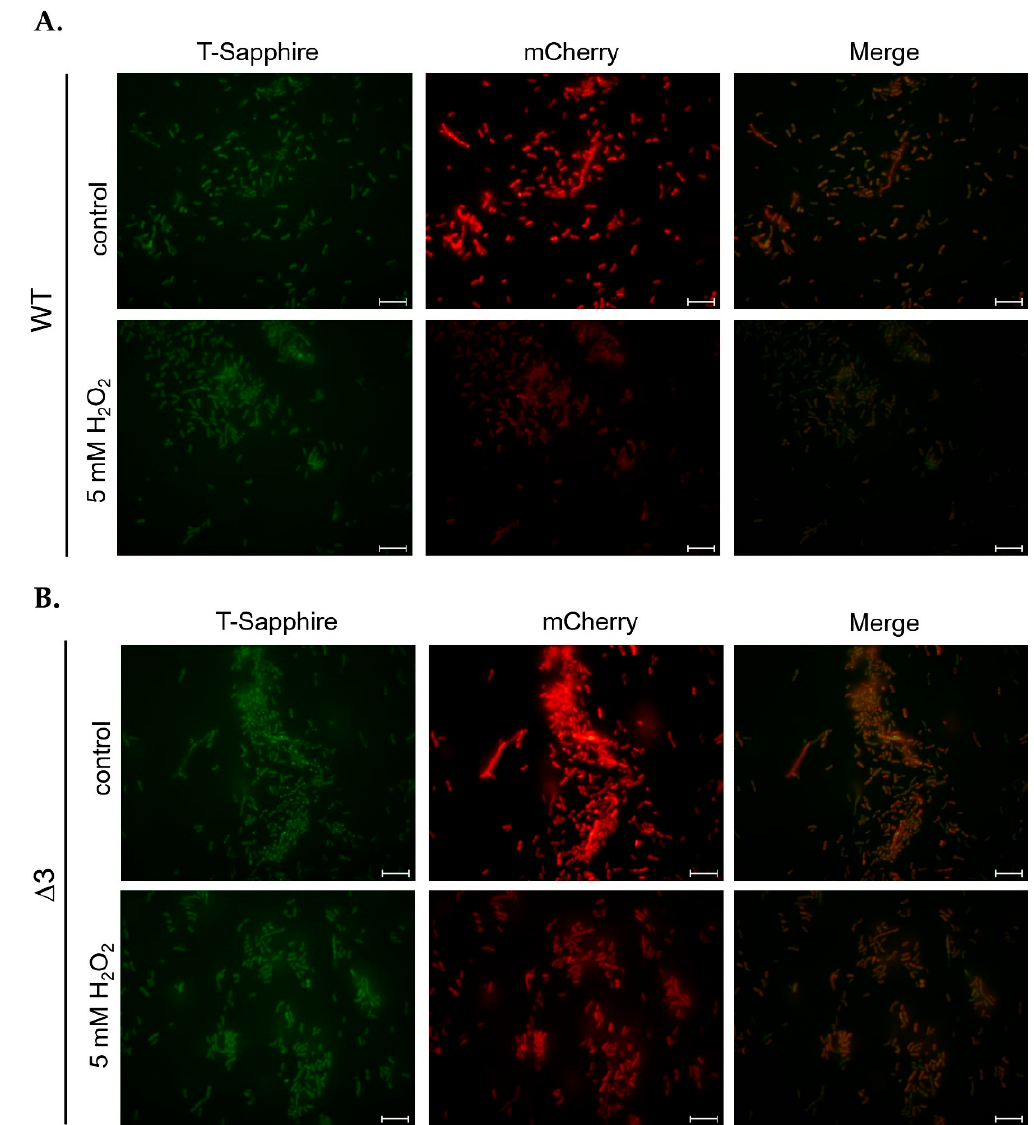
Figure 8. Fluorescence analysis of A. baumannii ATCC 19606 ( A ) wild-type and ( B ) Δ 3 single mutant with a Peredox plasmid. Here, mCherry fluorescence reflects bacterial viability, while T-Sapphire fluorescence reflects redox changes in bacteria. A total of 5 µL of bacterial culture before (control) and after 5 mM H 2 O 2 treatment for 20 min were added to slides before observation, with mCherry images captured after 4 s of excitation at a wavelength of 587 nm, while T-Sapphire images were captured after 8 s of excitation at a wavelength of 400 nm. Scale bars: 10 µm.